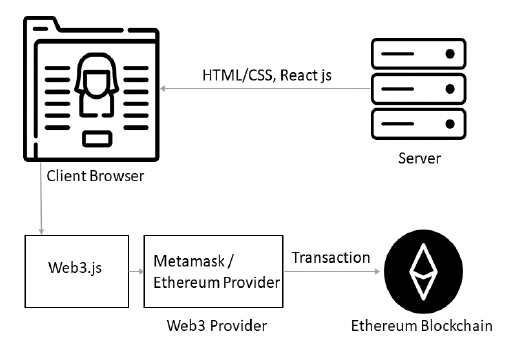
Figure 3: System Architecture [19].